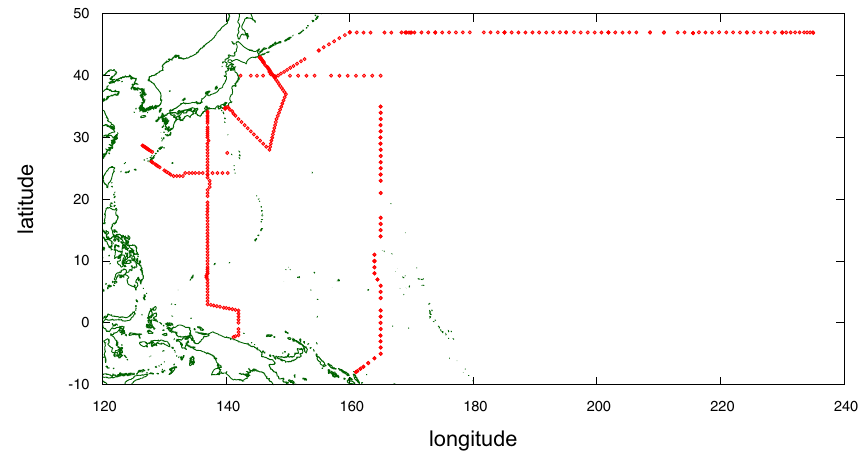
Figure 1. Horizontal locations of the observed profiles (red) and land–sea boundaries (green). The units of longitude and latitude are ◦ E and ◦ N ,